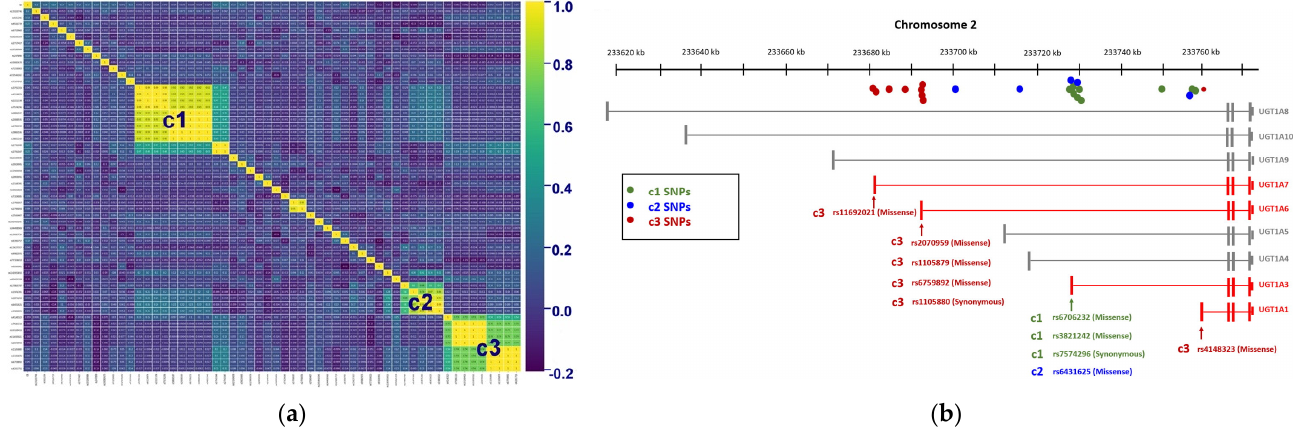
Figure 2. ( a ) Correlation matrix of 57 significant SNPs ( p < 0.05). There are three clusters (c1, c2, and c3) of SNPs that are highly correlated with each other ( r > 0.6). All clusters are located in the UGT1A region. ( b ) The graph shows the distribution of SNPs in the UGT1A region. The three clusters in the correlation matrix are represented by green (c1), blue (c2), and red (c3). Most c1 and c2 SNPs are clustered near the first exon of UGT1A3 , and three of them belong to missense variants. Except for rs4148323, which is the missense variant of UGT1A1 , the other c3 SNPs are concentrated between the first exon of UGT1A7 and the first exon of UGT1A6 , and most of them are missense variants of UGT1A7 or UGT1A6 .